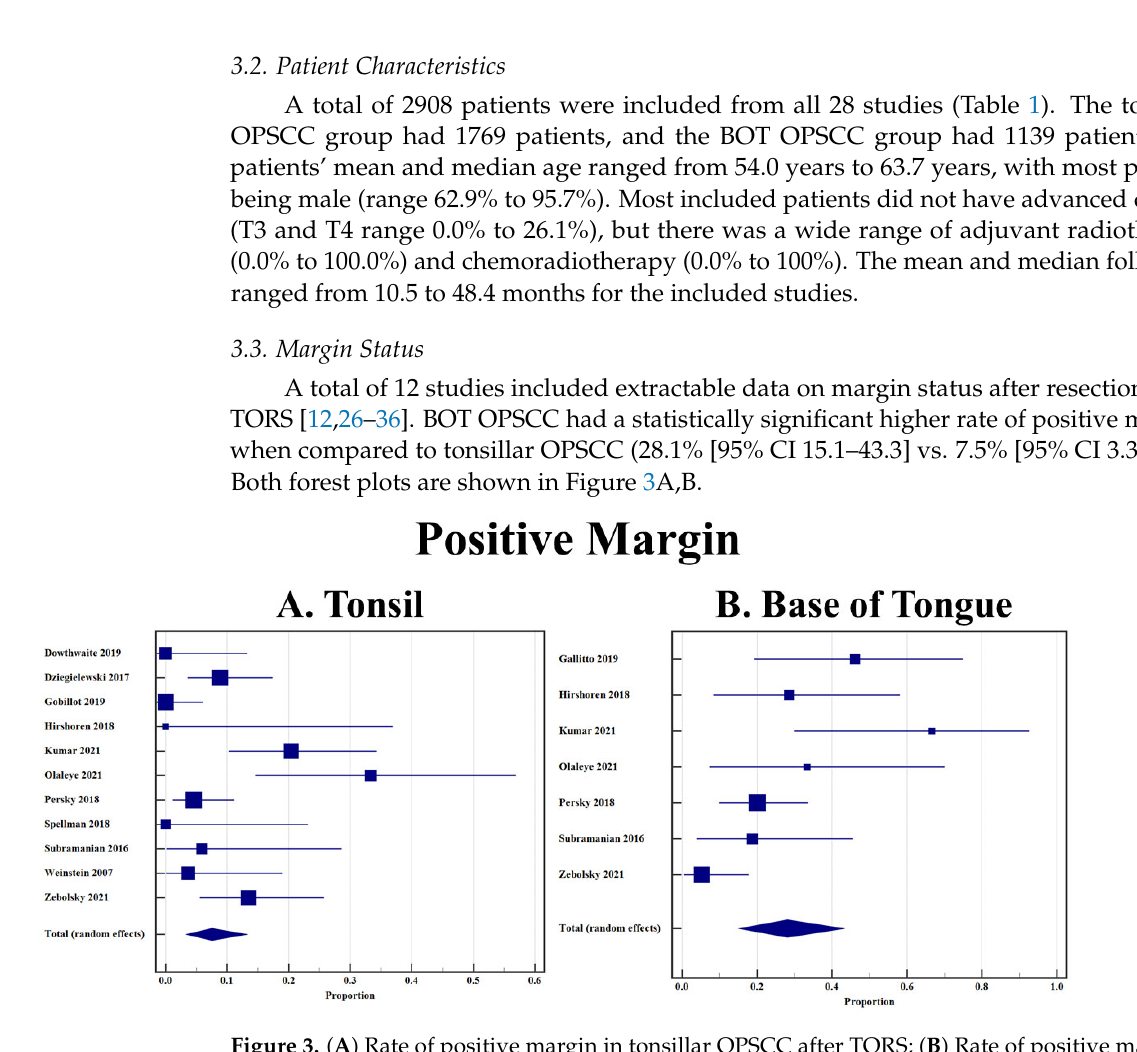
Figure 3. ( A ) Rate of positive margin in tonsillar OPSCC after TORS; ( B ) Rate of positive margin in base of tongue OPSCC after TORS.